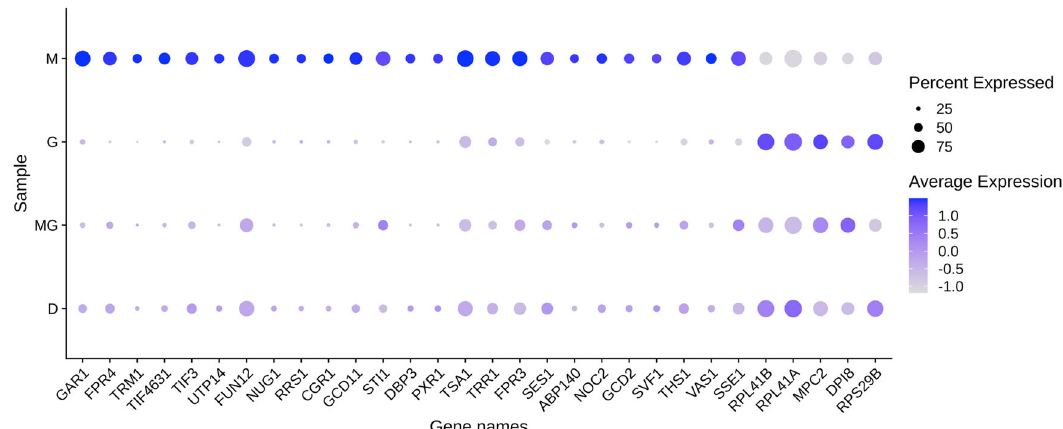
Fig. 4 DE genes in the 4 samples. Dotplot showing the key DE genes (Methods) identi fi ed in the 4 samples (D n = 233, G n = 258, M n = 85, MG n = 268 cells). The size of the dot represents the percentage of cells within a sample expressing the corresponding genes, while the color represents the average expression level in natural-log scale of the corresponding genes across all cells within a sample (blue is high). DE genes means differentially